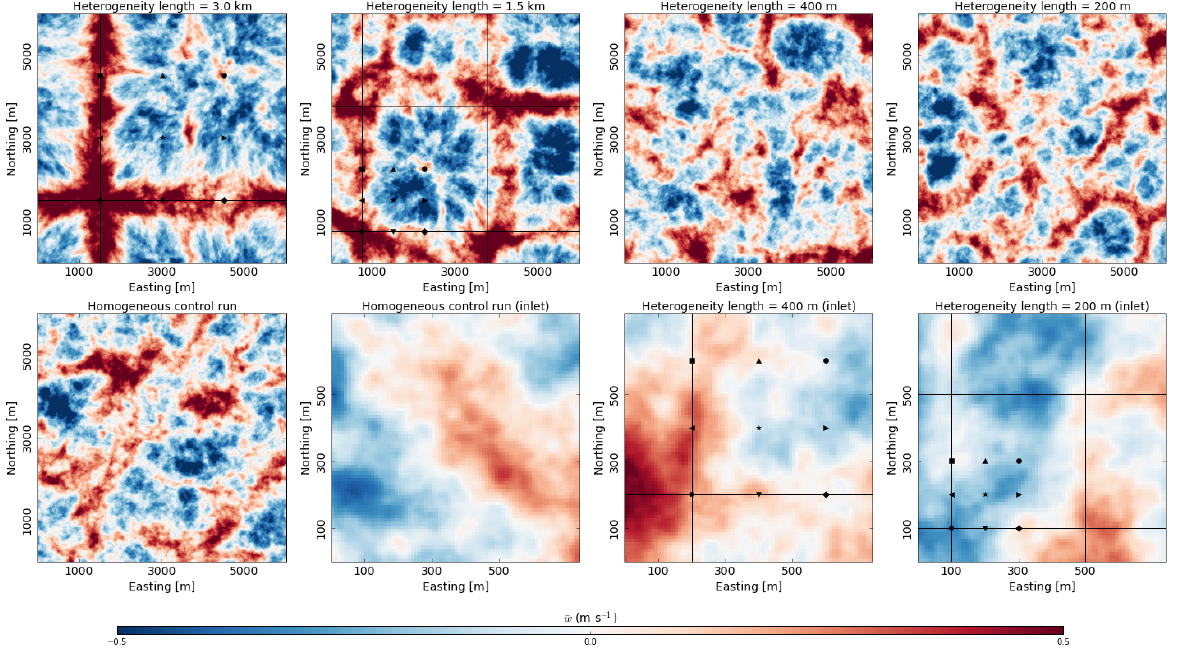
Figure 3. Analysis of the circulation patterns induced by the surface heterogeneity by means of the vertical velocity ( w ) averaged over the 4h data output, including a homogeneous control run. The results are for a particular surface amplitude of A x = A y = 0 . 3 and with L x = L y ( z = 50m). For reference the tower locations are indicated as well, as is the center of the “hot” patches by means of a black line. The plots of the whole domain for O (hm) show their similarity with the homogeneous control run. For the O (hm) heterogeneity we show an inlet around the towers, as the correspondence with the surface heterogeneity is otherwise hard to visualize, due to the smallness of the heterogeneity